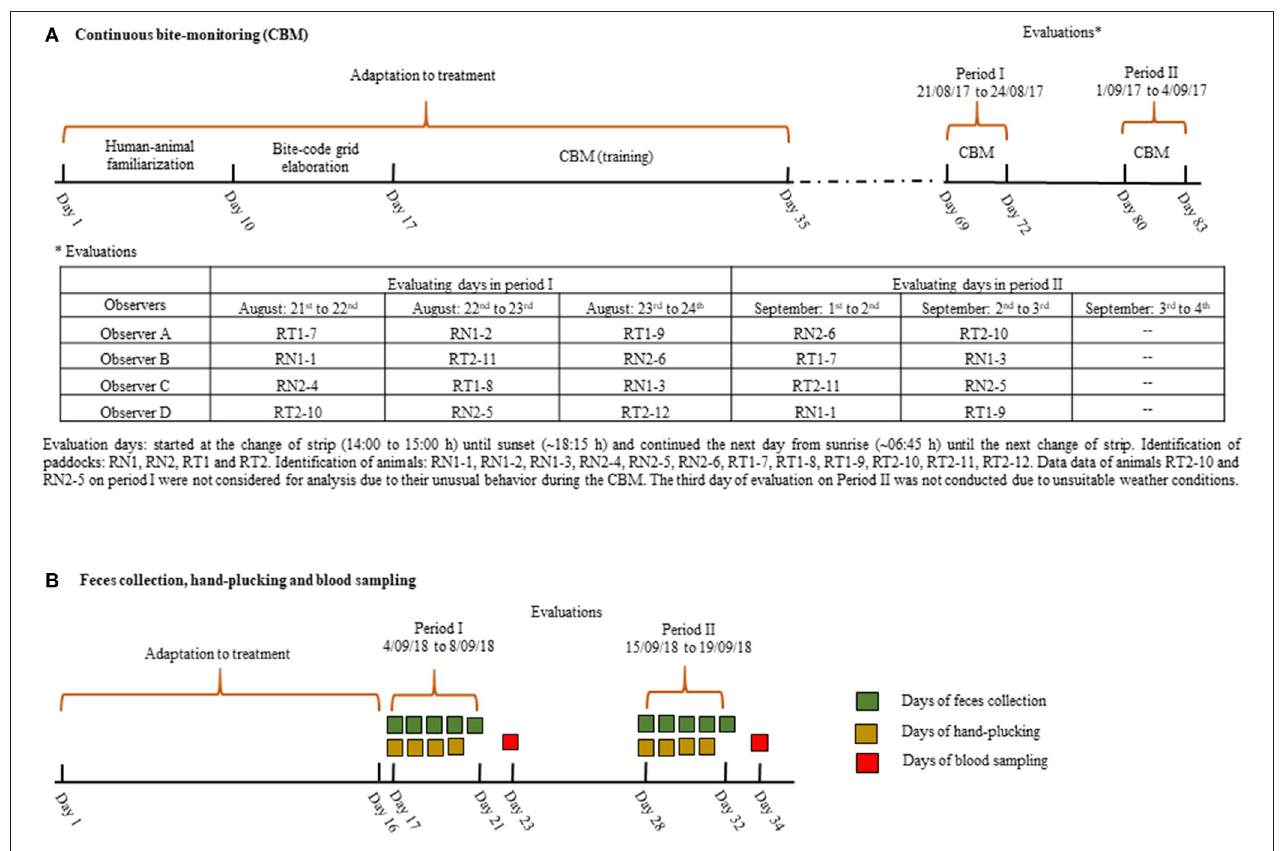
FIGURE 1 | Experimental scheme during the continuous bite-monitoring (CBM) in 2017 (A) , and feces collection, hand-plucking and blood sampling in 2018 (B)